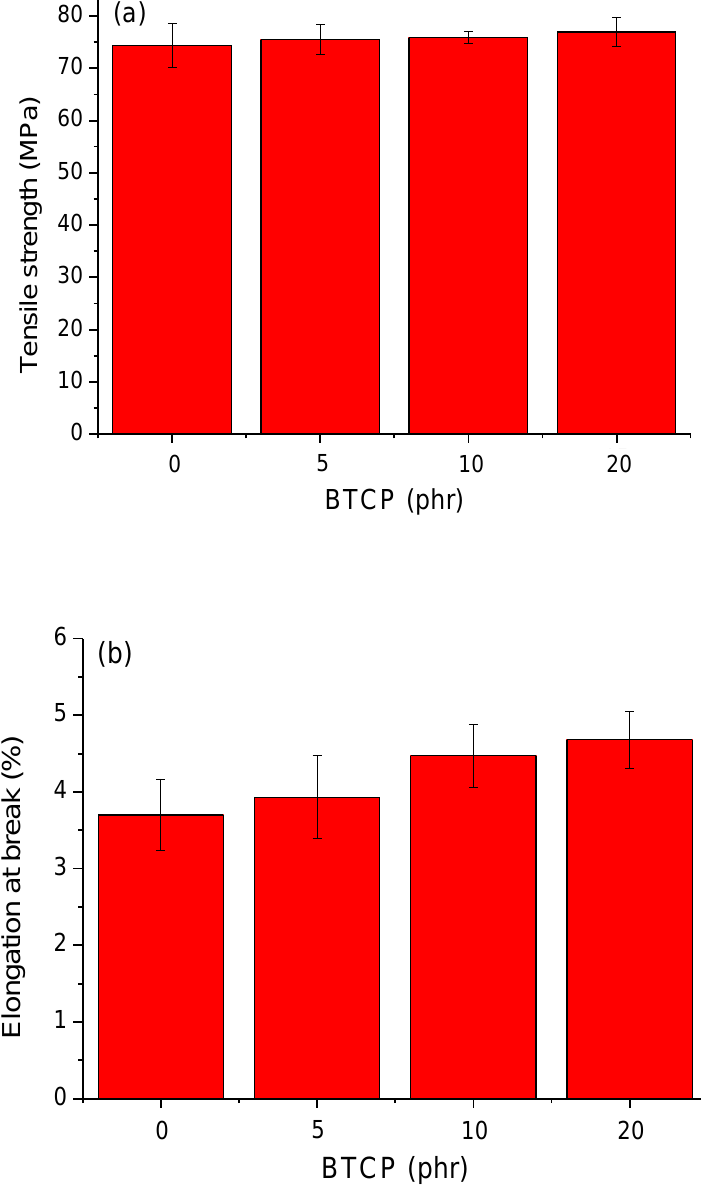
Figure 8. Universal tensile testing: ( a ) tensile strength and ( b ) elongation at break of cured epoxy compositions.